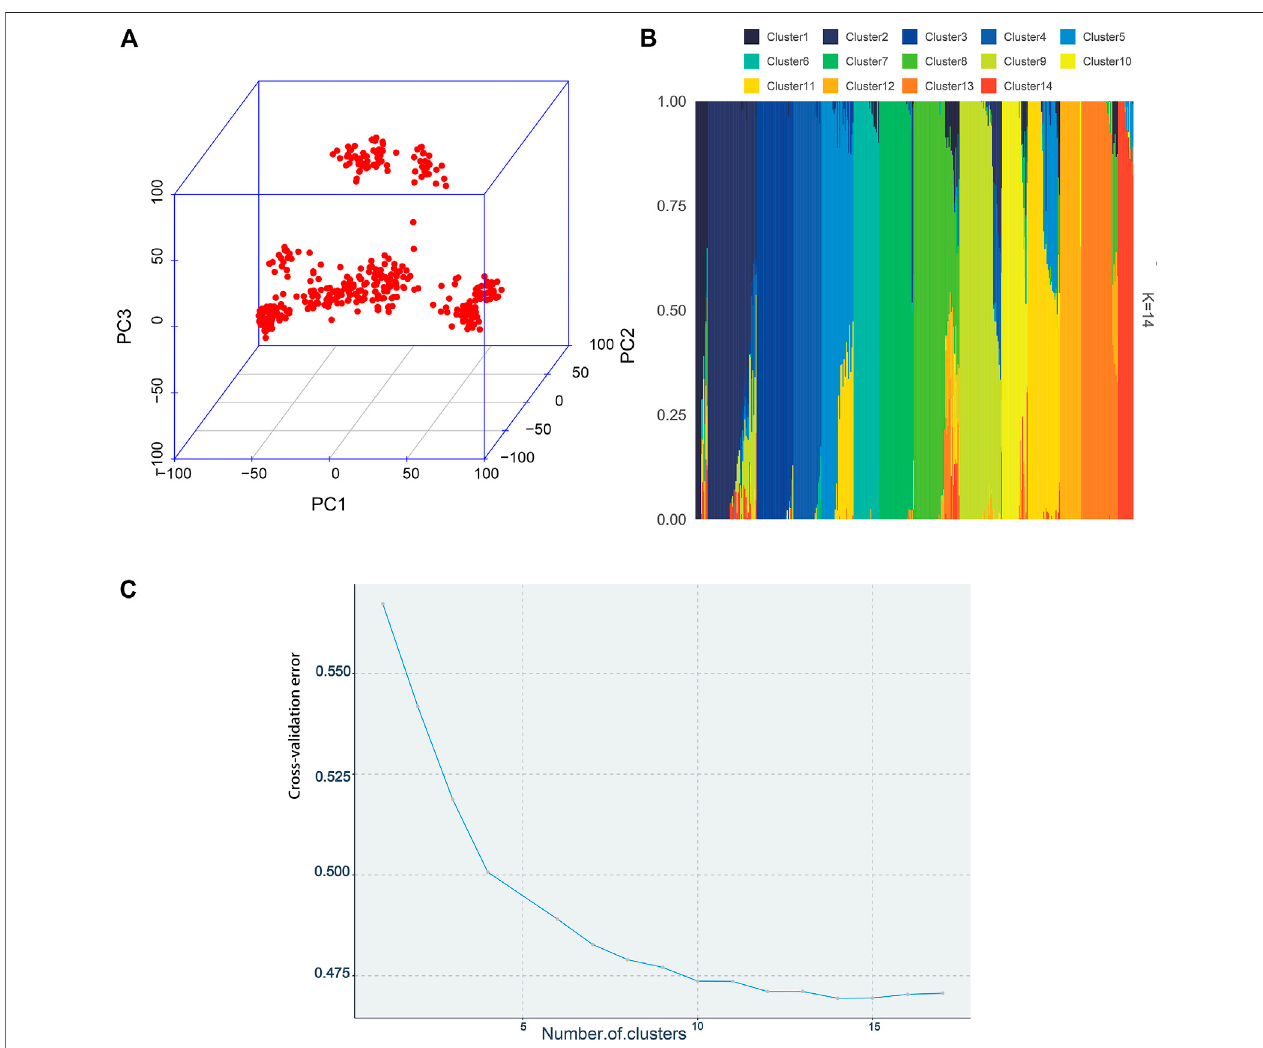
FIGURE 3 | Population structure plots demonstrated by the 395 individuals. (A) By constructing the 3D plot, the fi rst three PCs were chosen to depict the population structure. (B) Admixture analysis. Each bar represents an individual. Different colors represent various genetic clusters, and the proportion of the color represents the likelihood of an individual being allocated to that genetic cluster. The individuals were sorted by aligning clusters using the alink function of R package pophelper. (C) Cross-validation errors across 17 ancestral genetic clusters.